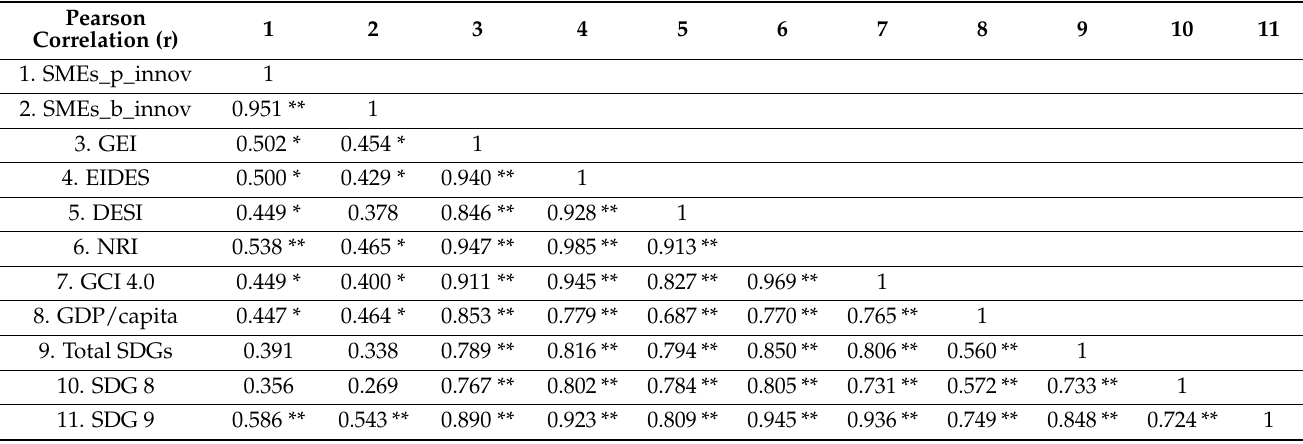
Table 2. Correlation